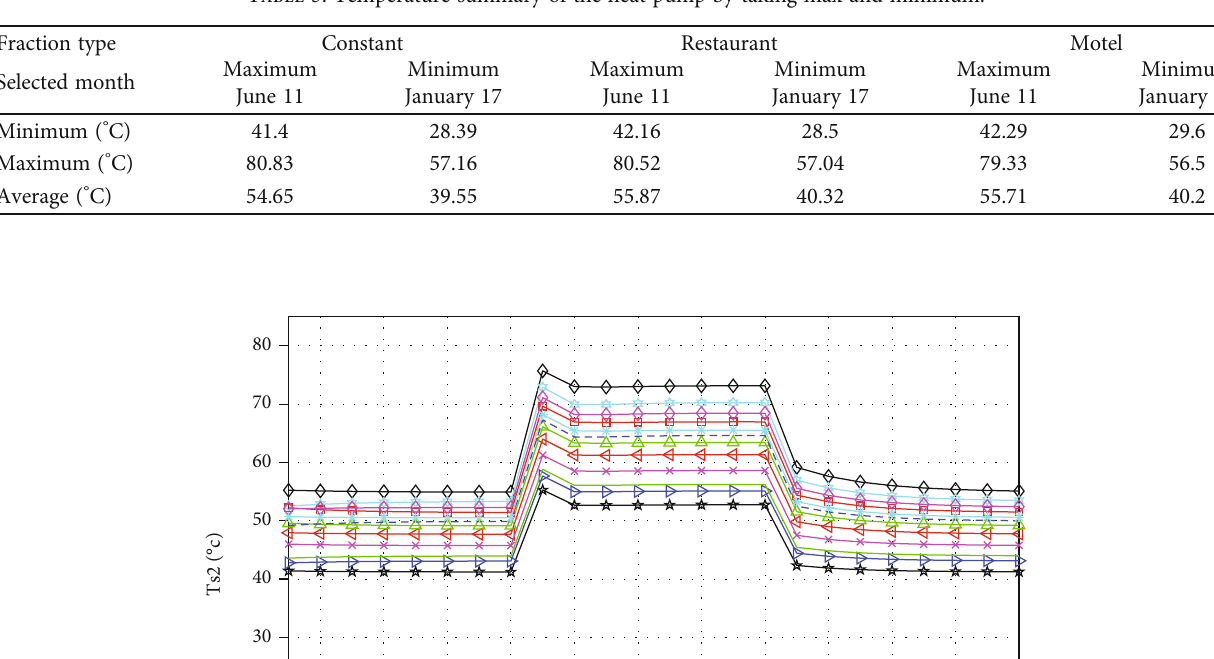
Table 5: Temperature summary of the heat pump by taking max and minimum.